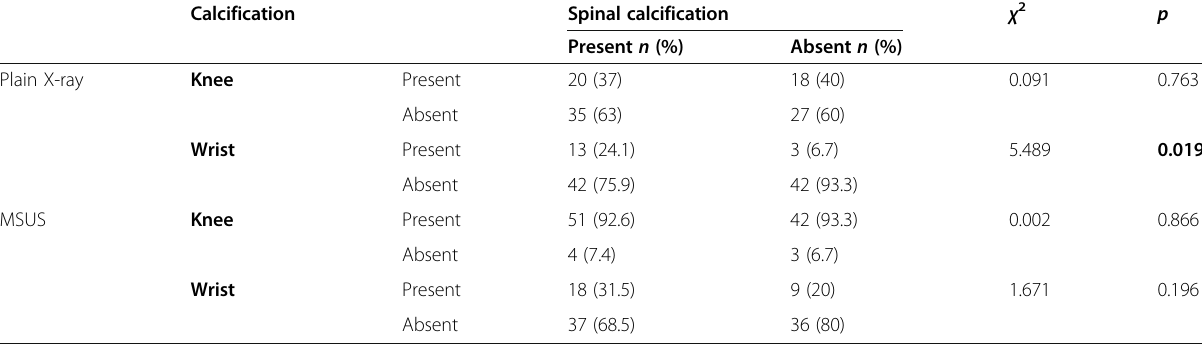
Table 2 Relation between the presence of spinal calcification and the presence of calcifications characteristic of CPPD deposition in the knee and wrist joints detected by conventional radiography and MSUS in the studied